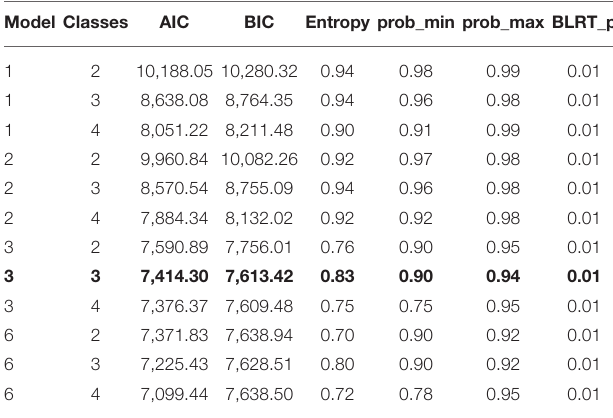
TABLE 1 | Latent profile fit statistics for attribute preference model with four models and five profiles. Model